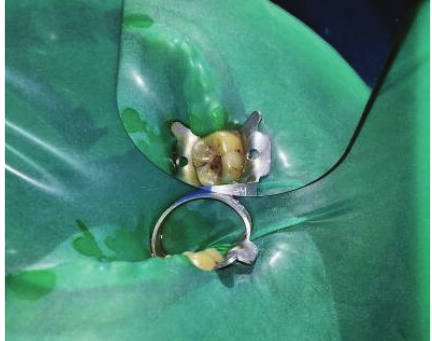
Figure 1: Preoperative